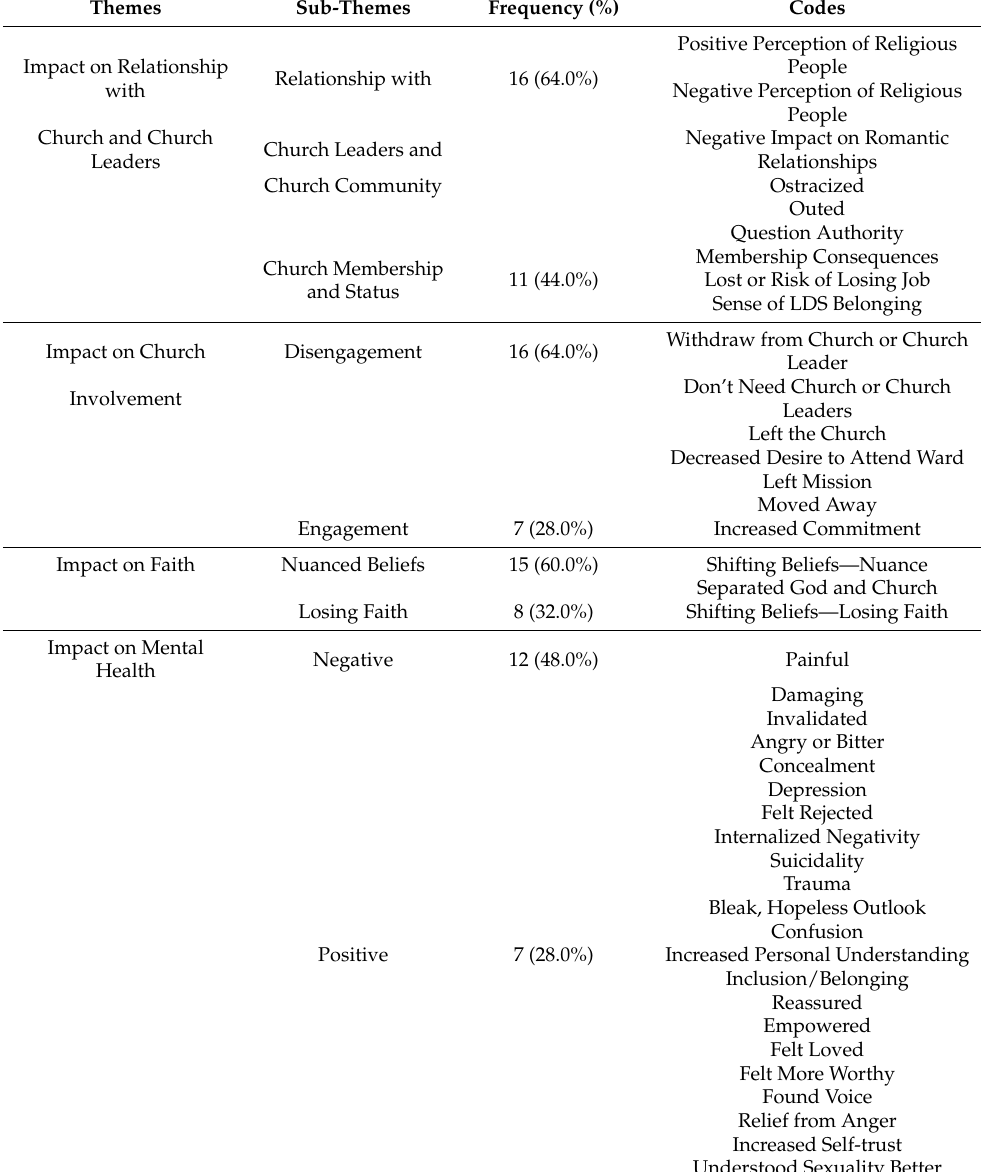
Table 4. Impact of counsel: themes, sub-themes, frequencies, and